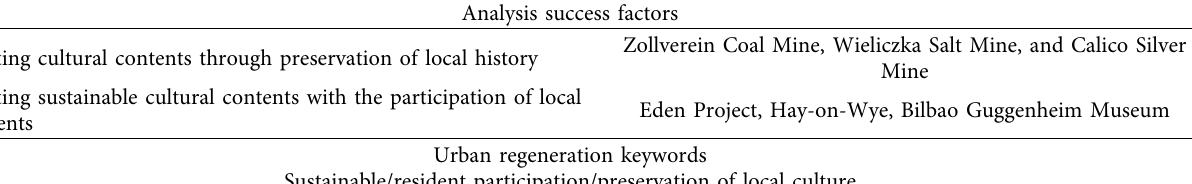
Table 8: Analysis of success factors for urban regeneration in Western abandoned mine areas.